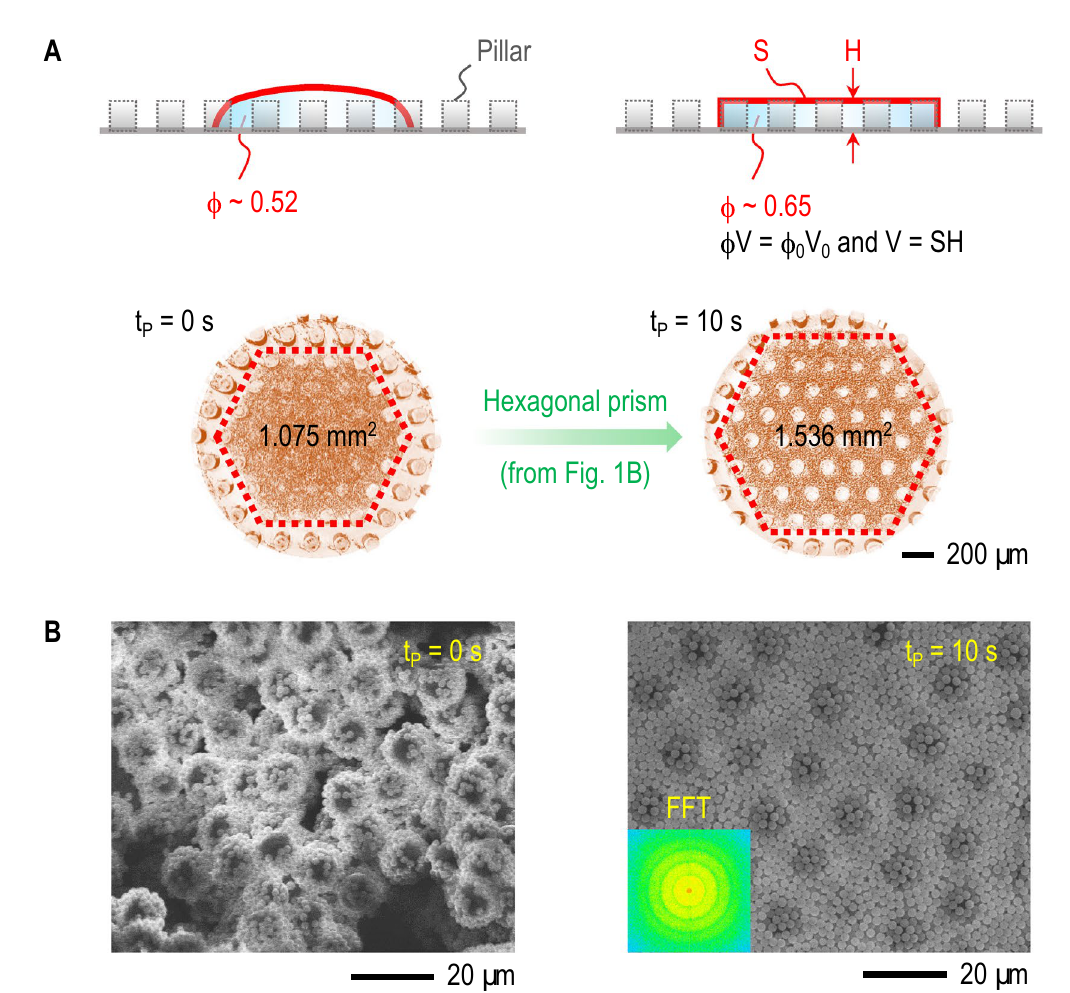
Figure 4. High-density deposition of binary colloids. ( A ) Schematic illustration with bump (left) and without bump (right): volume conservation ( φ V = φ 0 V 0 ) and hexagonal prism model ( V = SH ) suggest high-density deposition of binary colloids with the final packing density φ ∼ 0.65 by the plasma treatment ( t p = 10 s) (Generated with Amira software (version 2019.3)). ( B ) Scanning electron microscopy (SEM) images on the deposit top layers: (left) large particles surrounded by small particles behave like single-sized large particles, and (right) small particles fill voids between large particles, creating dense packing (Acquired with S-3000H, Hitachi). The FFT (fast Fourier transform) of the right SEM image, taken by ImageJ, indicates that binary colloids build randomly packed noncrystal structures (inset). Optimal high-density packing is achieved when small and large particles are uniformly mixed by the mixing volume ratio of ω m = 0.5 (=